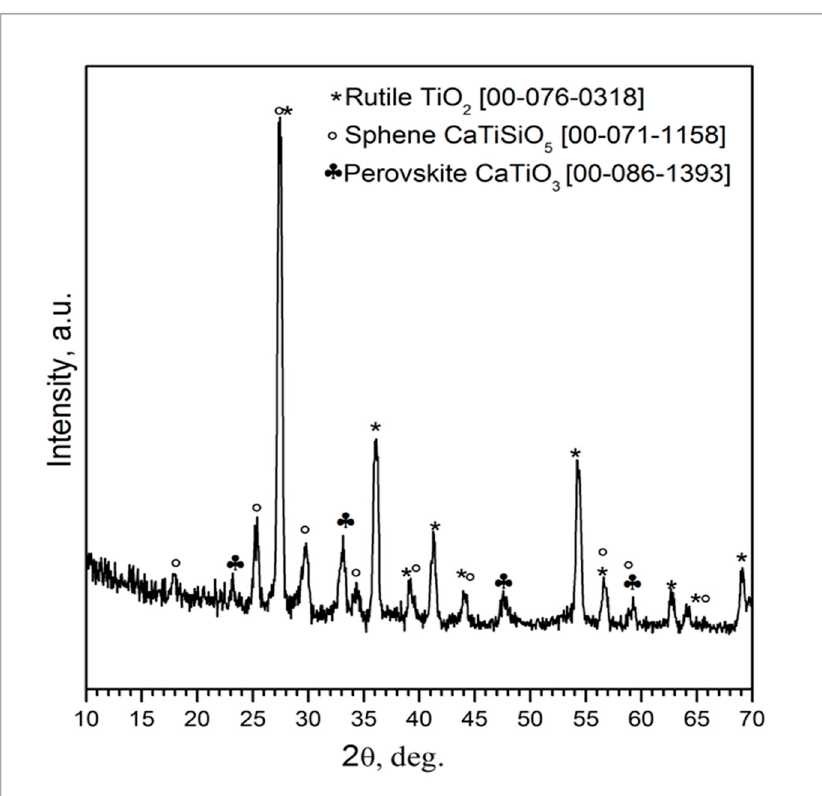
Figure 2. XRD pattern of sphene-coated cpTi after heat treatment at 950 °C in air for 1 h.